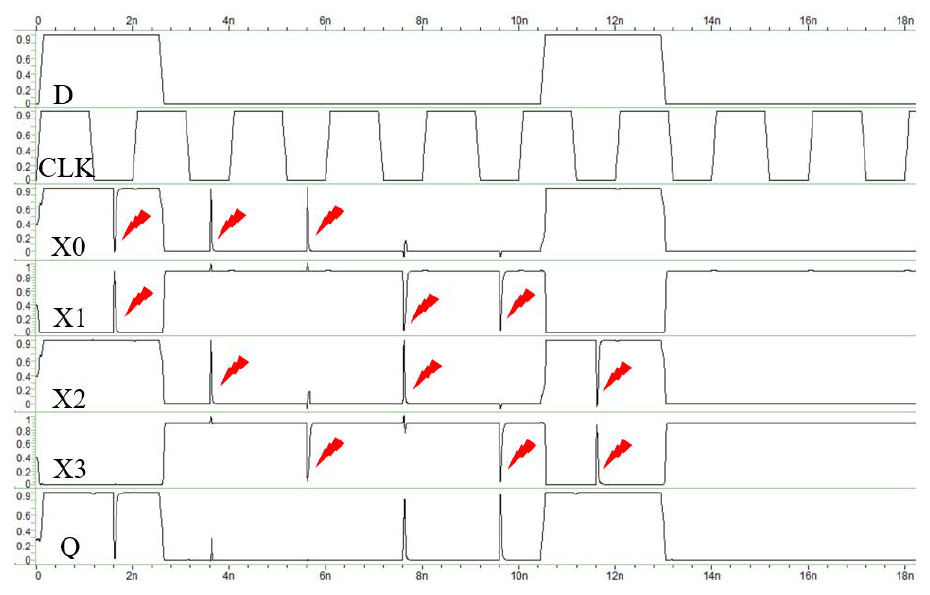
Figure 13. Simulation result during SEDU injection.